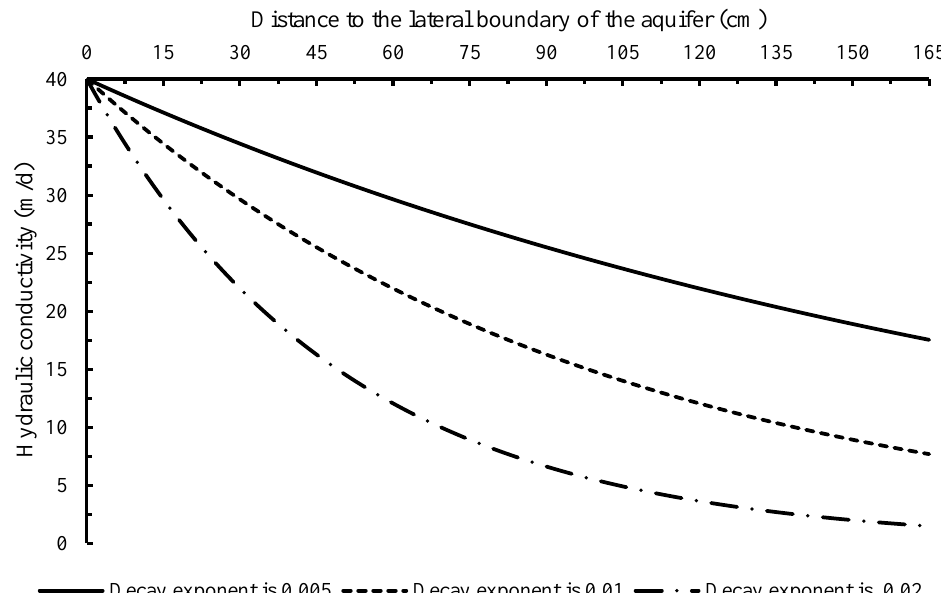
Figure 6. The exponential relationship between hydraulic conductivity and length.